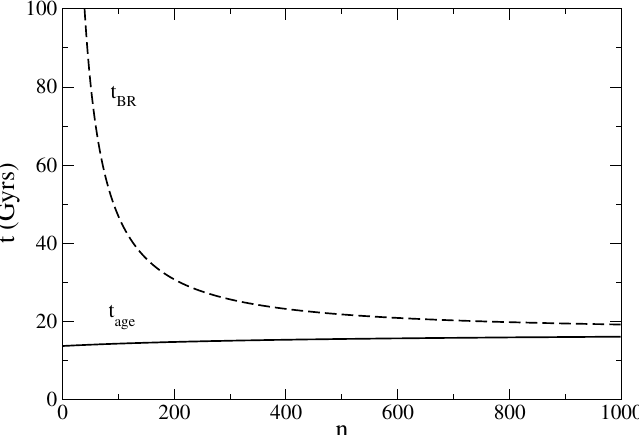
Figure 3. Age of the Universe t age and big rip time t BR as a function of n